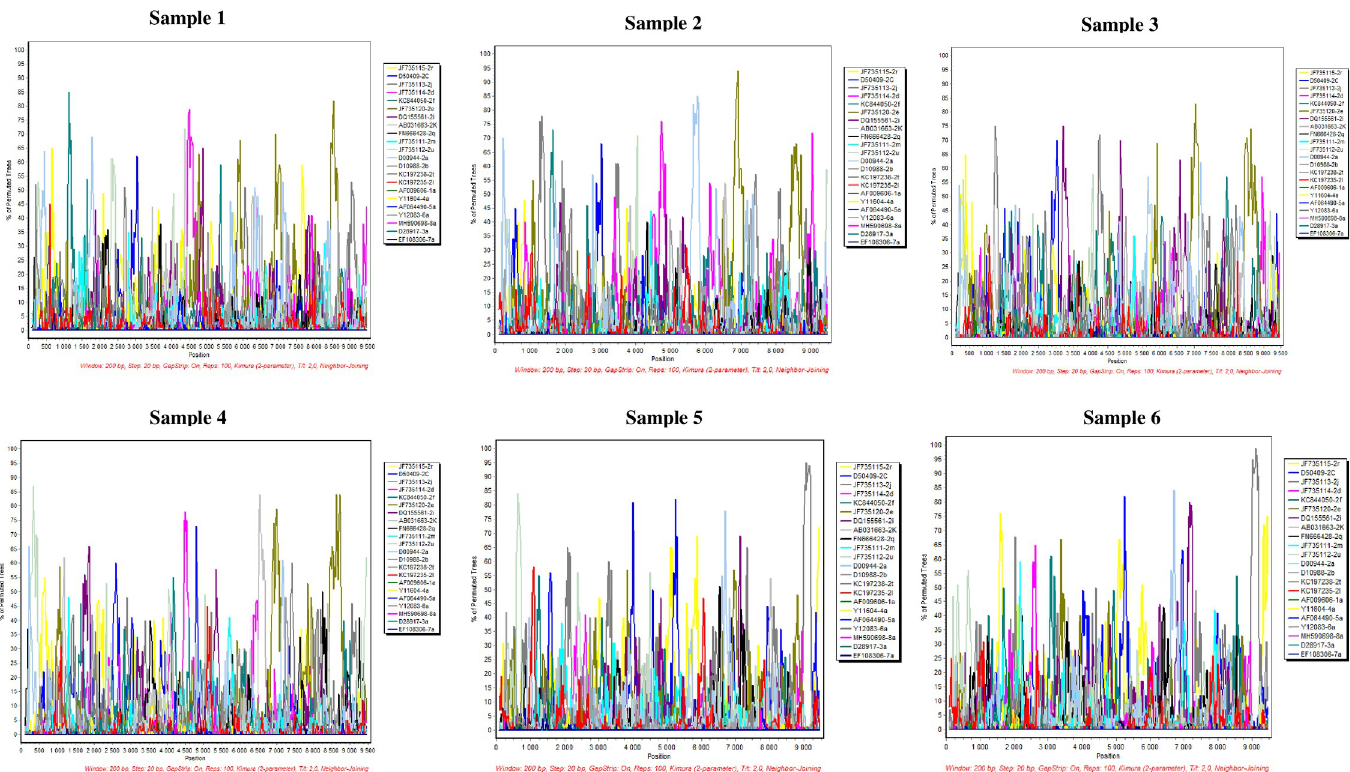
Fig 3. Absence of recombination in the HCV-2 Tunisian strains by BootScan analysis. BootScan analysis of nucleotide sequences of HCV-2 Tunisian strains as queries compared to previously established HCV genotypes and HCV-2 subtypes. The nearly complete genome sequences were included in the analysis (95.8% (9243nt) of full HCV genome by reference to the AF009606 sequence). Nucleotide sequence positions are indicated on the x-axis.